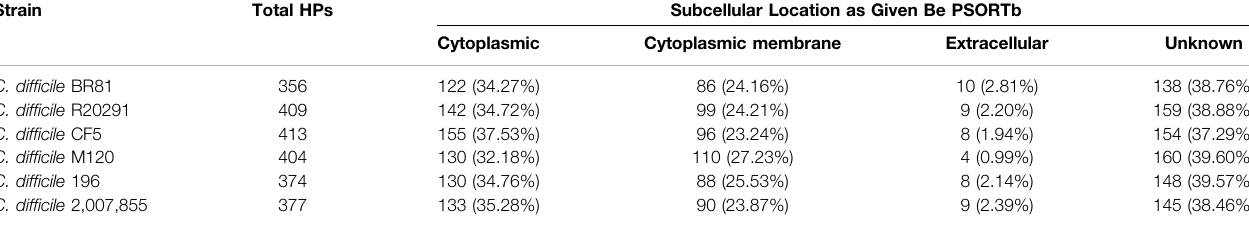
TABLE 4 | Subcellular localisation of C. dif fi cile strains hypothetical proteins determined by PSORTb. Strain Total HPs Subcellular Location as Given Be